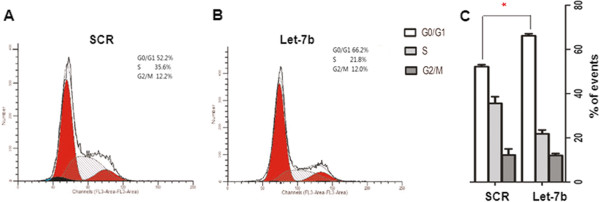
Let-7b increased cisplatin induced G0/G1 arrest. U251R cells were transfected with scramble (SCR) (A) or Let-7b mimics (B) and then treated with cisplatin; cell cycle was detected by flow cytometry. The percentage of cells in different cell cycle phases was calculated (C). Data is presented from three independent experiments, and the symbol * indicates statistical difference (p < 0.05).